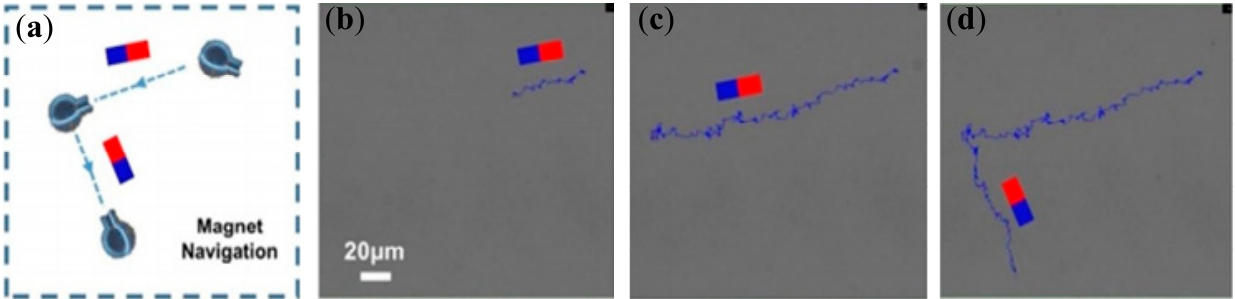
Figure 4. ( a ) The directional motion trajectories motors under the action of magnets. ( b – d ) The motion direction of nanobottle motors is consistent with the magnets. The scale bar is 20 μ m. Reprinted with permission from Ref. [43]. Copyright 2022, copyright Wiley-VCH GmbH.